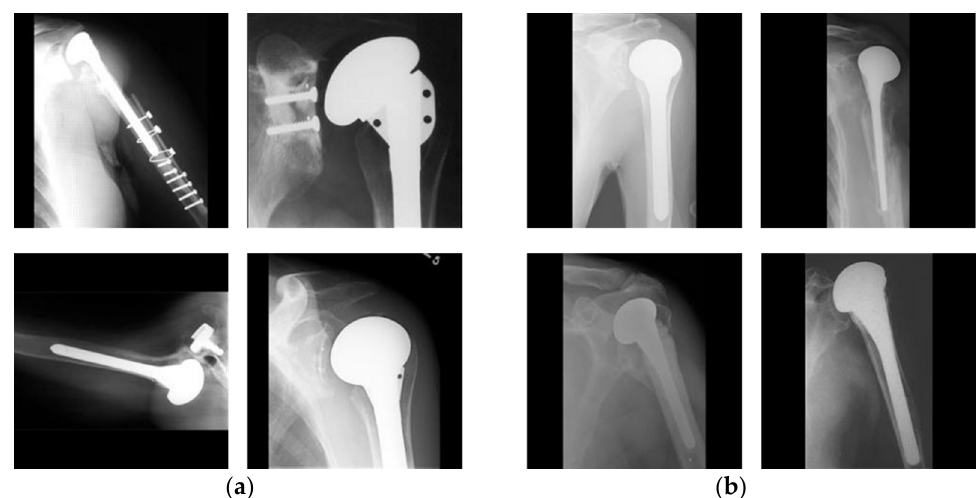
Figure 1. Examples showing high intra-class variabilities and low inter-class variabilities. Examples showing ( a ) high intra-class variability of one manufacturer (Cofield) and ( b ) low inter-class variability. In ( b ), upper-left, upper-right, lower-left, and lower-right images show the cases of four manufacturers of Cofield, Depuy, Tornier, and Zimmer, respectively.